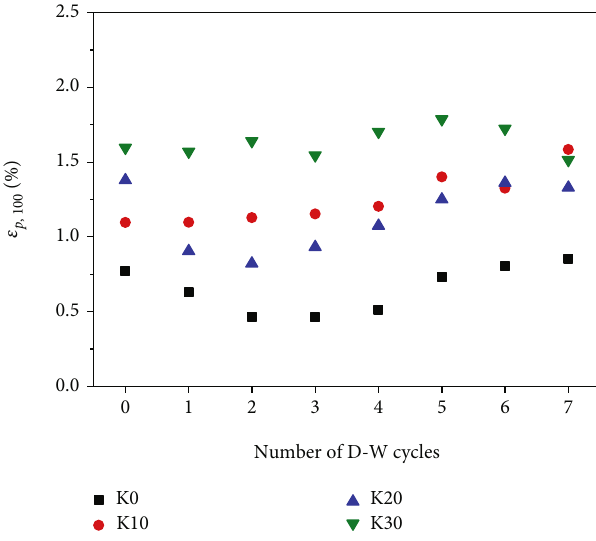
Figure 21: Fitting parameter “ b ” versus D-W cycles number.